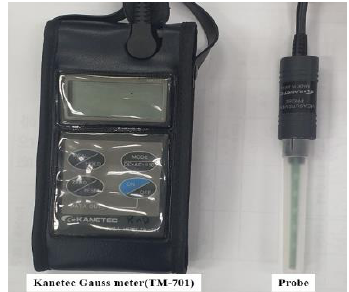
Figure 3. Set-up of Kanetec Gauss meter.